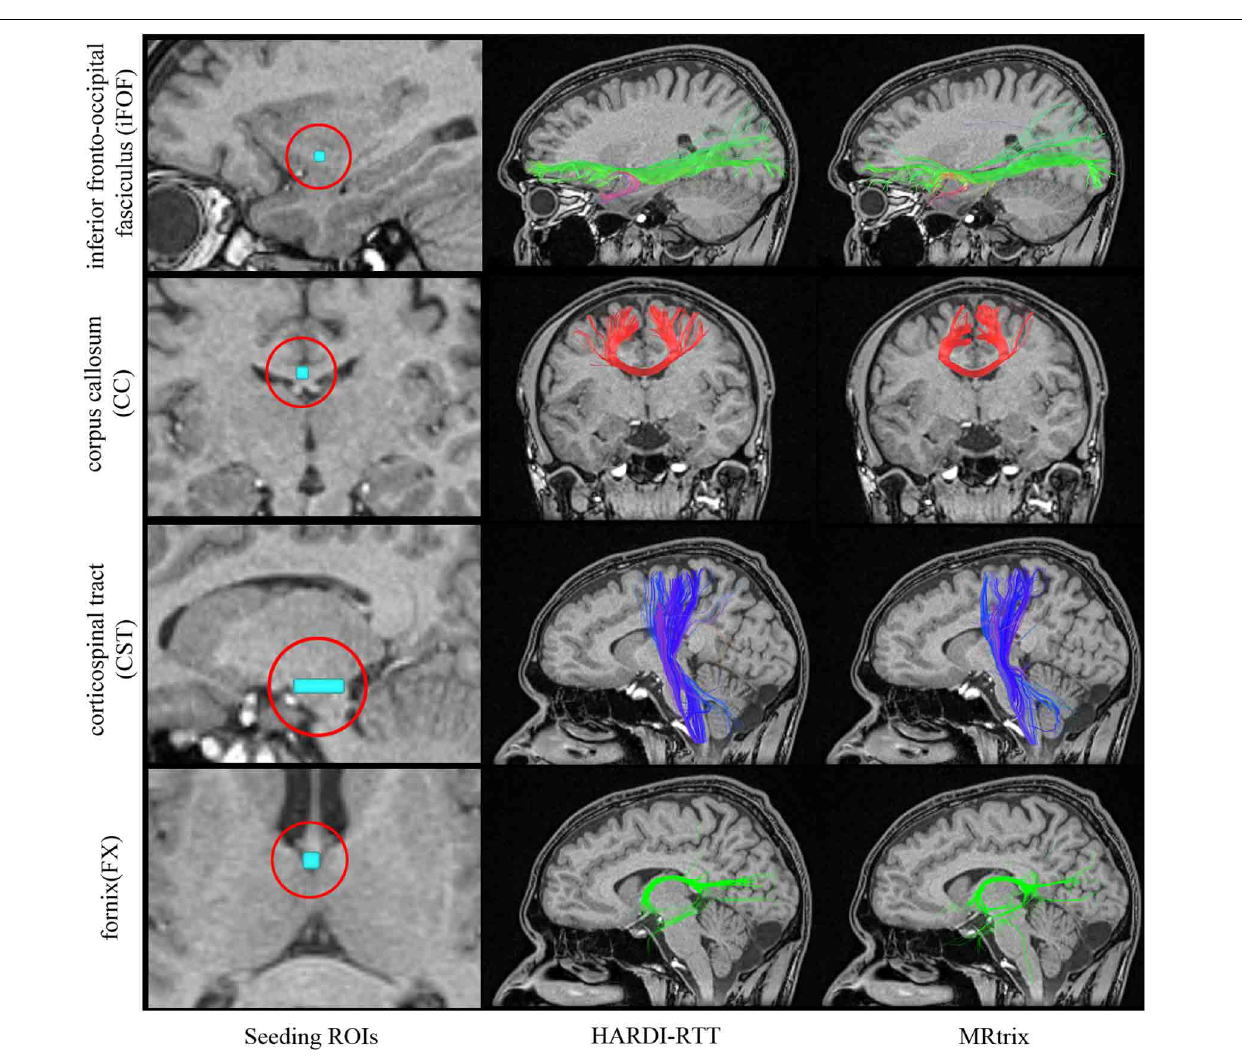
FIGURE 6 | Qualitative analysis of 1000 streamlines generated from VOIs placed in specific regions of the brain (left column). iFOF: VOI was placed in the inferior frontal lobe. CC: ROI located at the middle of the CC. CST: Elongated VOI located at the pontine nuclei level. FX: Seeds where initiated